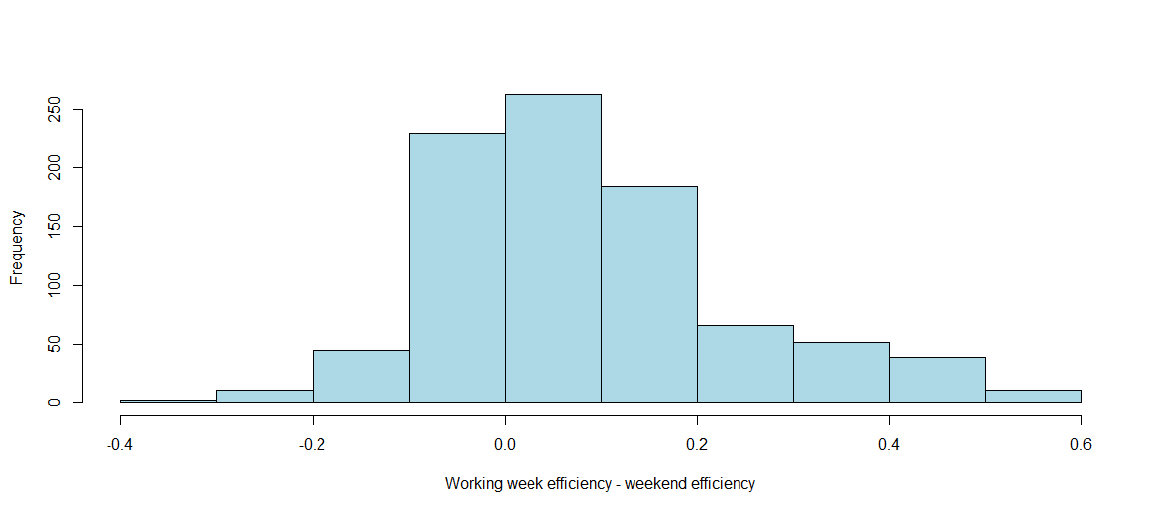
Figure 1. Histogram of observed efficiency differences between working week and